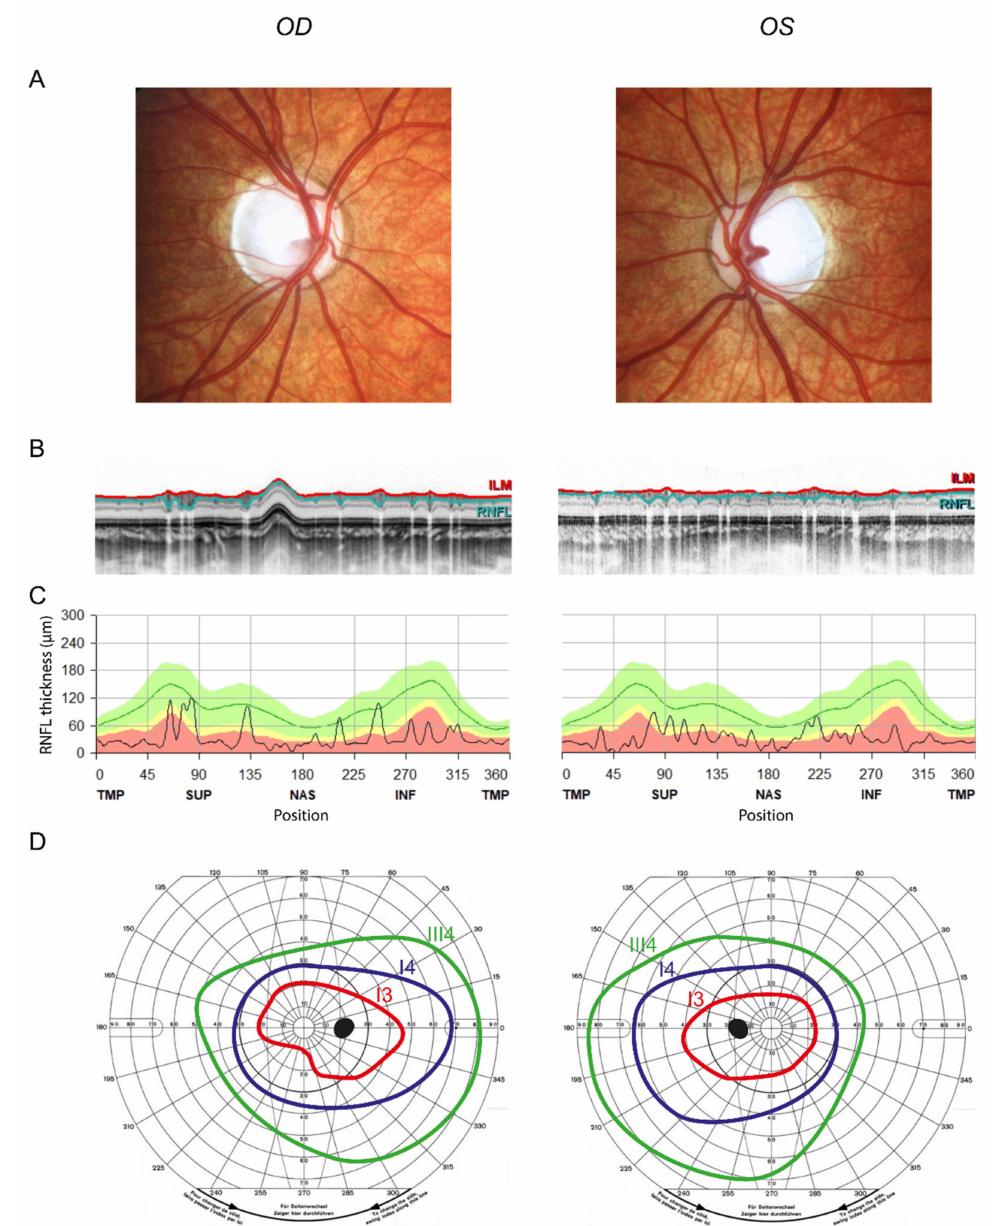
Figure 1. Severe optic atrophy in the son. ( A ) Fundus images showing temporally accentuated optic pallor. ( B ) Circumpapillary OCT scan (ILM in red and the border between GCL and RNFL in turquoise). Note the thinning of the RNFL. ( C ) Peripapillary RNFL thickness in all sectors, showing severe circular optic atrophy. ( D ) Goldmann perimetry showing a relatively central scotoma. Isopters: red = I3; dark blue = I4; green = III4. Note that isopter I1 was not seen. OD = right eye, OS = left eye, OCT = optical coherence tomography, ILM = internal limiting membrane, GCL = ganglion cell